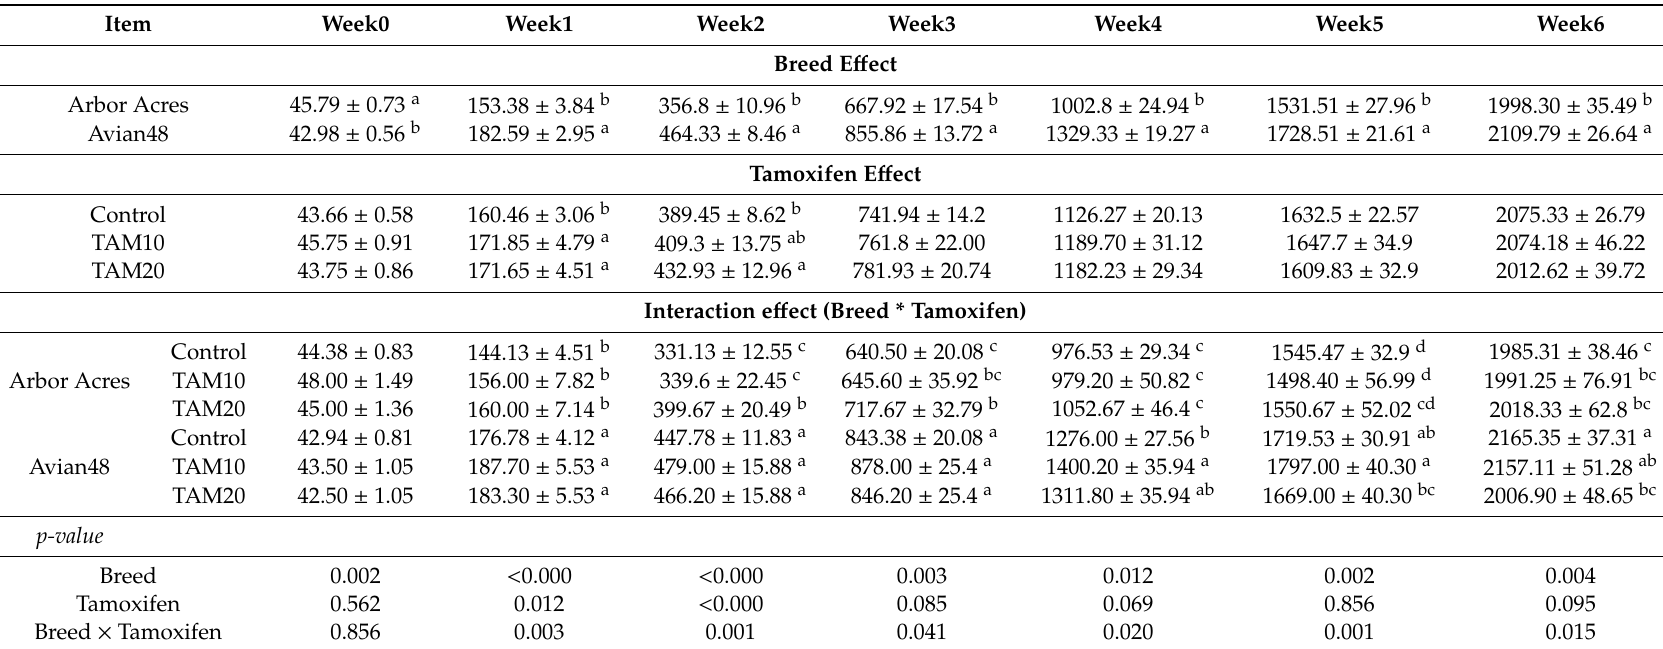
Table 2. The e ff ect of breed, Tamoxifen treatments and their interactions on weekly body weight (Means ± SE).